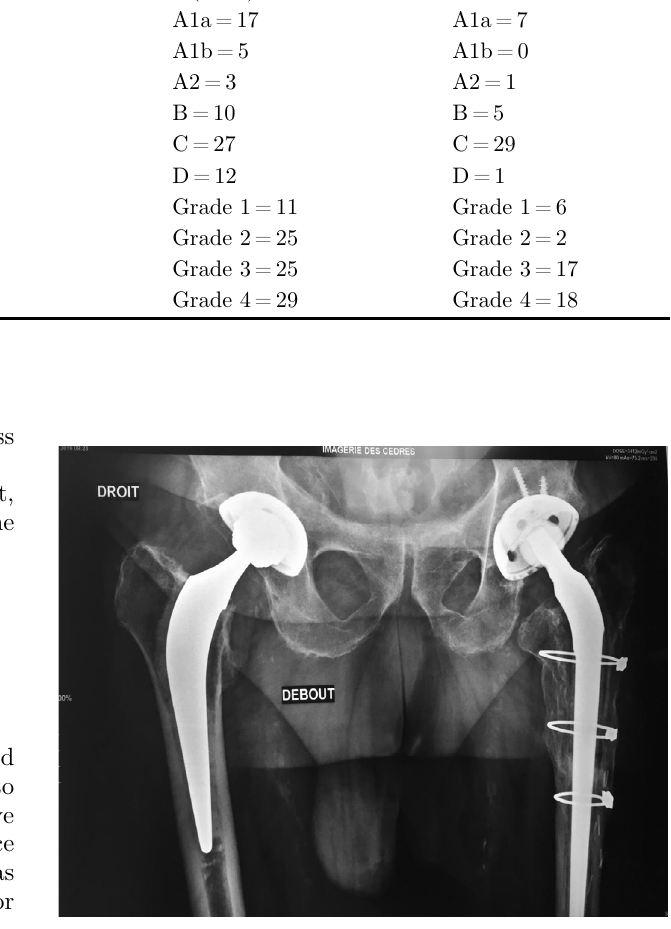
Figure 7. ETO fi xed by